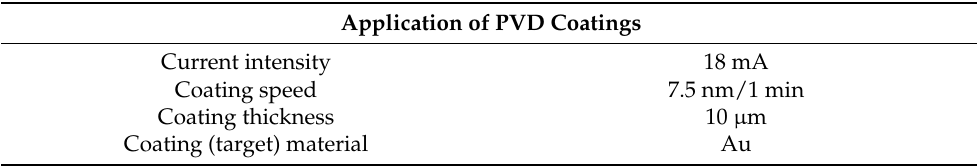
Table 4. Parameters of the Physical Vapor Deposition (PVD) coating